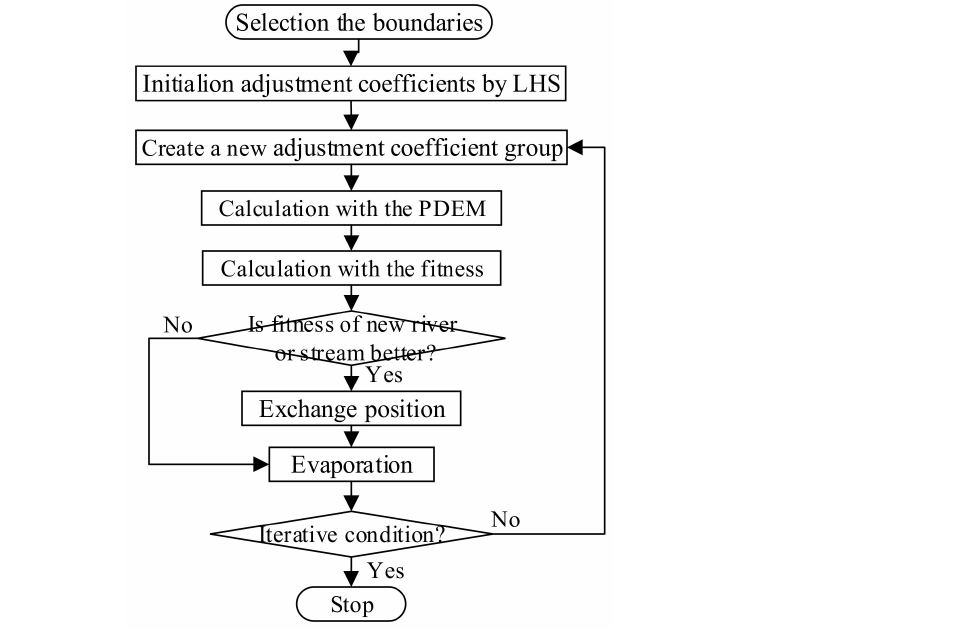
Figure 9. The calibration process of adjustment coefficients of viscous boundaries based on the